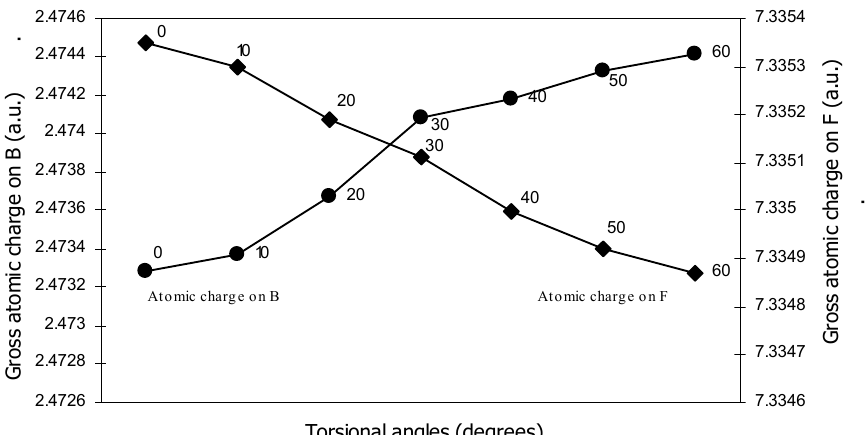
Figure 4. Plot of gross atomic charge densities on B and F atoms of F a function of torsional angles